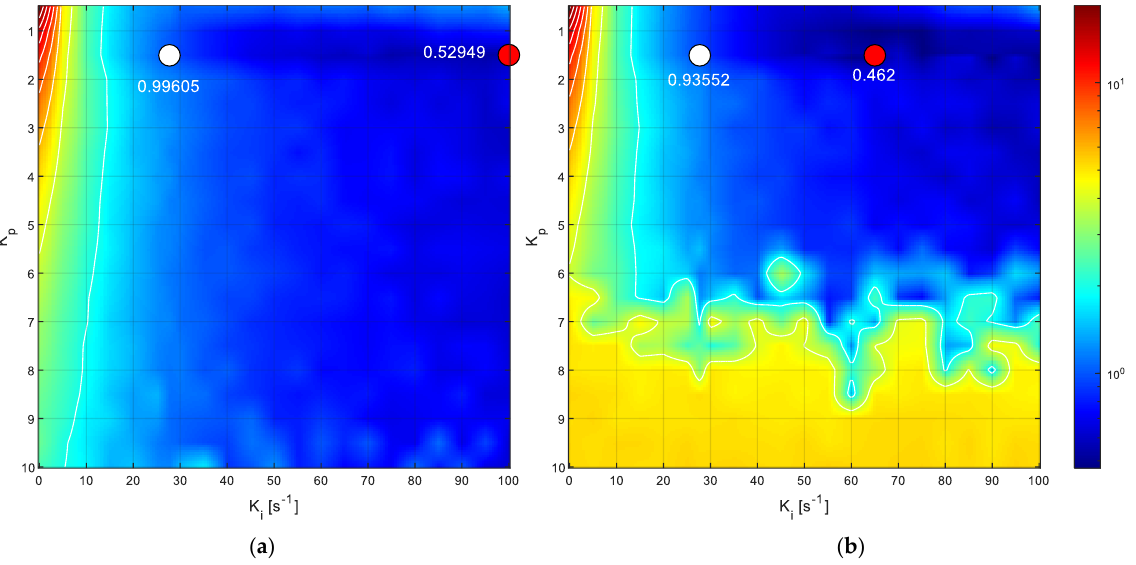
Figure 21. Details of the two horizontal planes defined in Figure 20. The white point depicts the location or projection of the NIAE baseline values obtained with the FRB PID tuner procedure while the red point depicts the location of the minimum NIAE in each plane. The values of the NIAE are also displayed for reference: ( a ) plane with 𝐾 𝑑 = 0.0182 s ; ( b ) plane with 𝐾 𝑑 = 0 s .